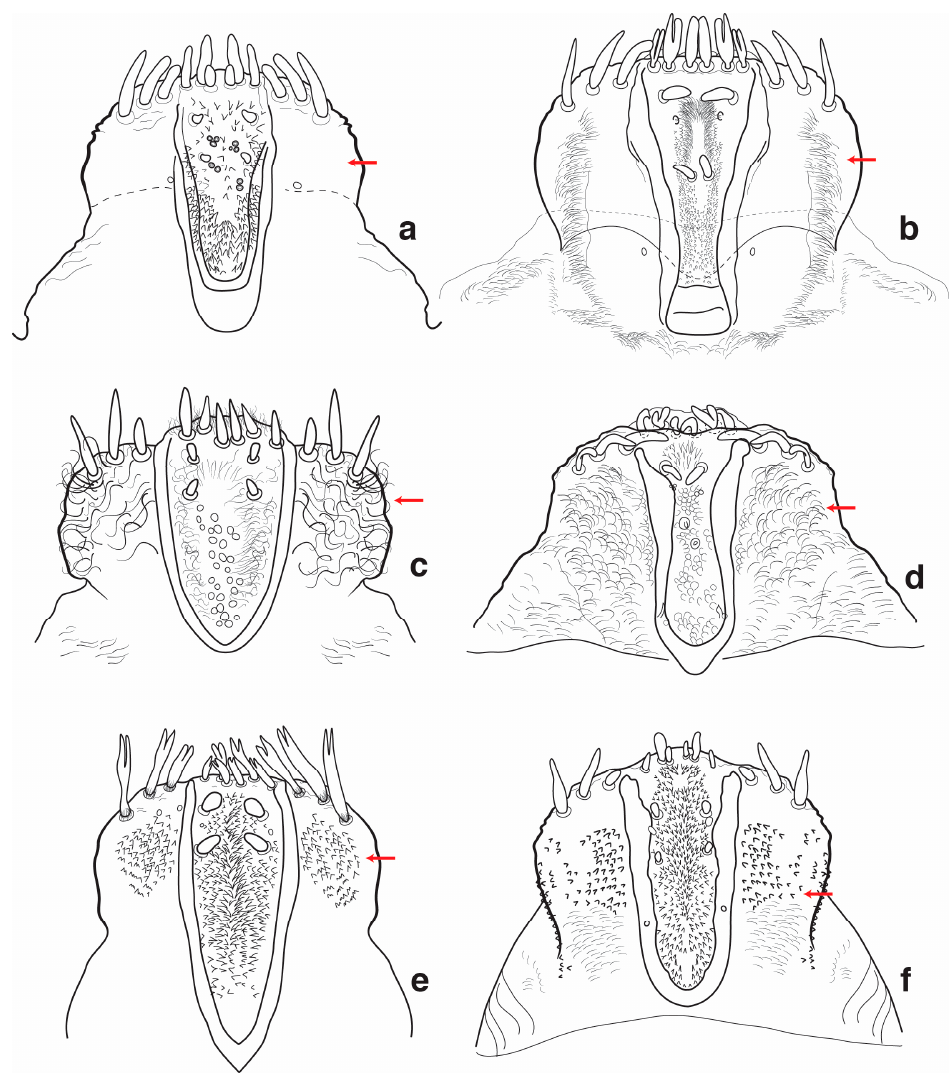
Figure 19. Epipharynx, larva: ( a ) Diocalandra ; ( b ) Metamasius ; ( c ) Nephius (= Anius ); ( d ) Trochorhopalus ; ( e ) Eugnoristus ; and ( f ) Phacecorynes . 6. Distribution of lateral microsetae/asperites of epipharynx (Figure 20) a